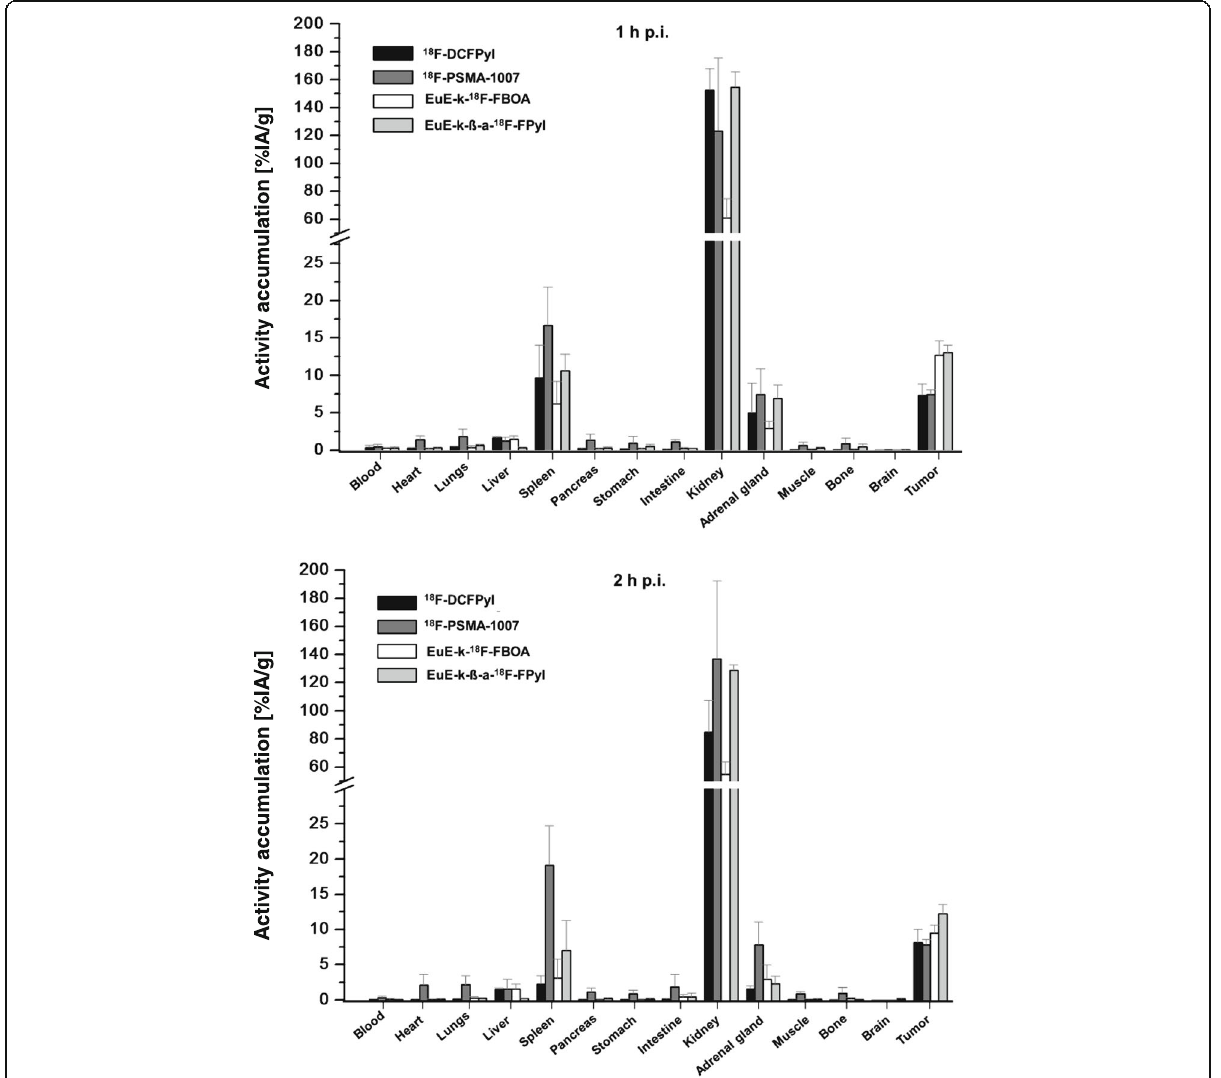
Fig. 4 Biodistribution of EuE-k- 18 F-FBOA and EuE-k- β -a- 18 F-FPyl in comparison to 18 F-DCFPyl and 18 F-PSMA-1007 in LNCaP-tumor-bearing SCID mice at 1 and 2 h p.i.. Data are given in % IA/g are means±SD ( n =4 animals per group and time